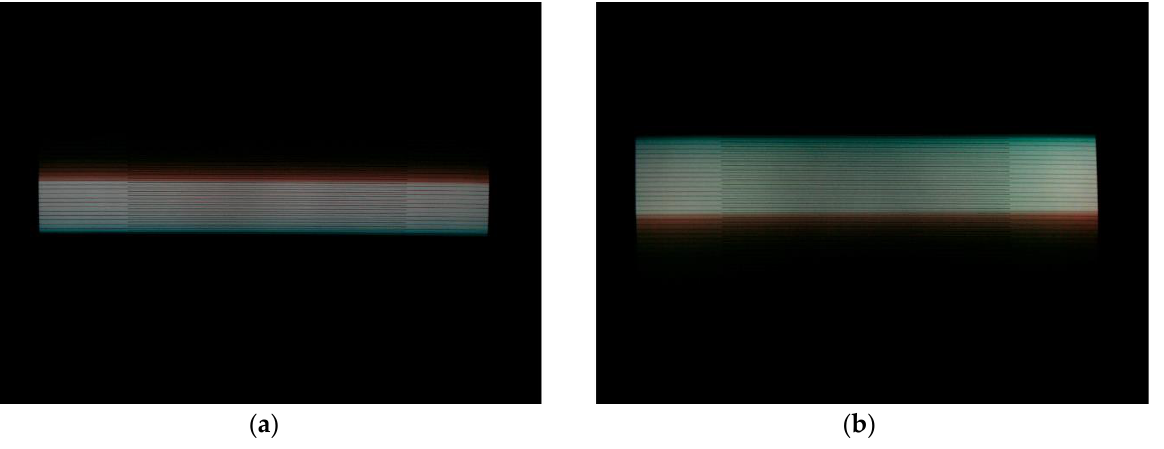
Figure 13. Example measurements of C2 with a monitor screen with 1/500 s. ( a ) camera in normal position, showing 120 lines. ( b ) camera upside-down, showing 163 lines.